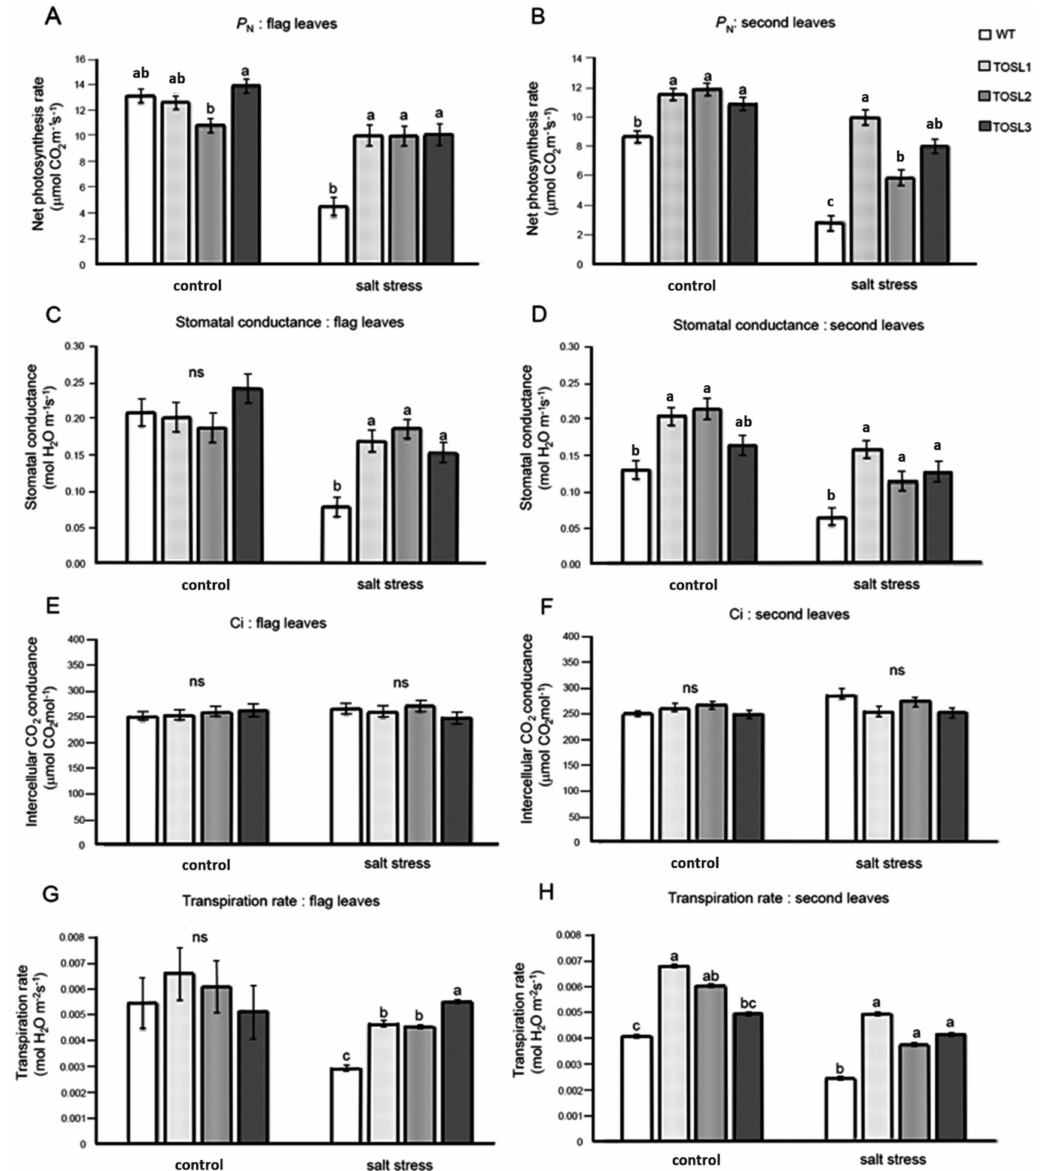
Figure 2. The net photosynthetic rate (P N ) ( A , B ), stomatal conductance (g s ) ( C , D ), intercellular CO 2 concentration (Ci) ( E , F ), and transpiration rate ( E ) ( G , H ) of flag leaves ( A , C , E , G ) and second leaves ( B , D , F , H ), when wild type (WT) and the OsNUC1–S overexpressing lines, TOSL1, TOSL2, and TOSL3, were grown under control or salt-stress conditions. The data were presented as the mean ± SE and a different letter above the bar showed the significant difference in means ( p < 0.05) based on Tukey’s range test analysis. ns represents no statistically difference among